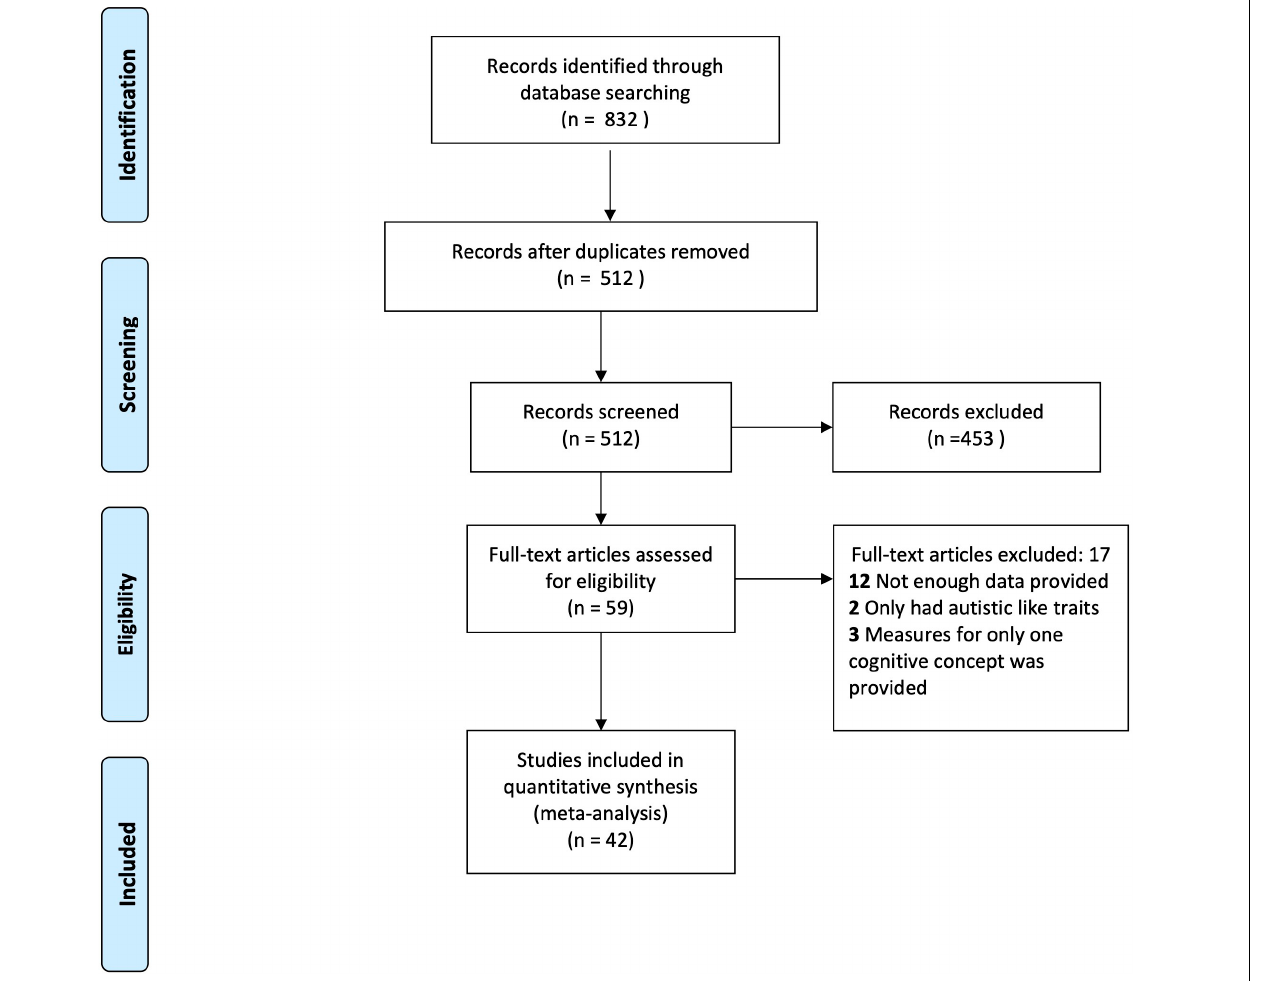
FIGURE 4 | PRISMA